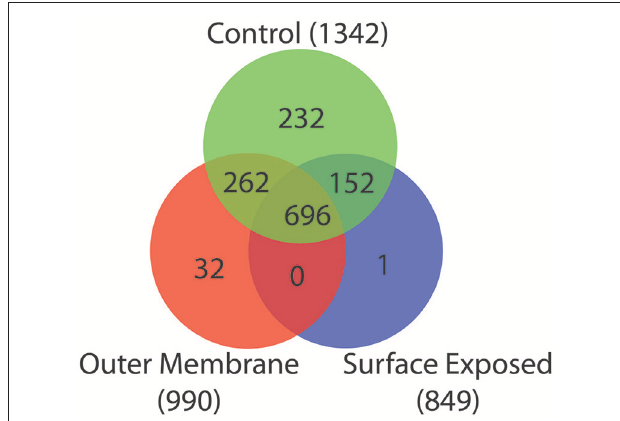
FIGURE 2 | Venn diagram of peptides detected from the three extraction methods. Overlap of peptides detected in the control sample (Green), OM extraction (Red), and SE extraction